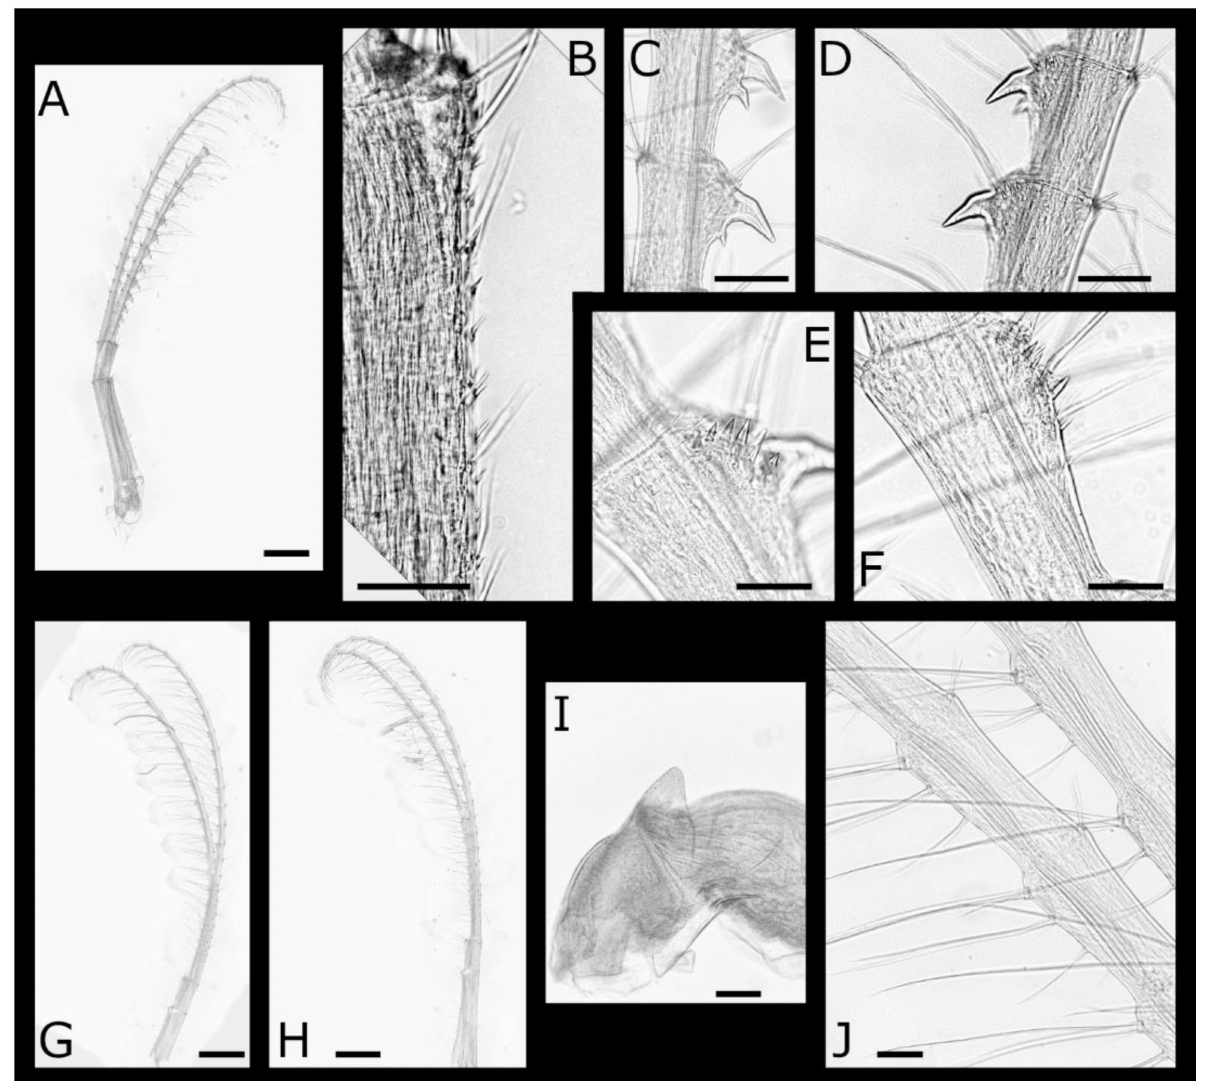
Figure 28. Pectinoacasta sculpturata (Broch, 1931) cirri IV–VI (WAM C61395). ( A ) left cirrus IV; ( B ) spinules on the anterior margin of cirrus IV protopod; ( C – E ) teeth and erect spines on basal segments of cirrus IV anterior ramus; ( F ) erect spines on medial segment of cirrus IV posterior ramus; ( G ) right cirrus V; ( H ) right cirrus VI; ( I ) basidorsal point of penis; ( J ) setation on medial segments of cirrus VI. Scale bars: A, G–H = 500 µ m; B, E–F, J = 50 µ m; C–D, I = 100 µ